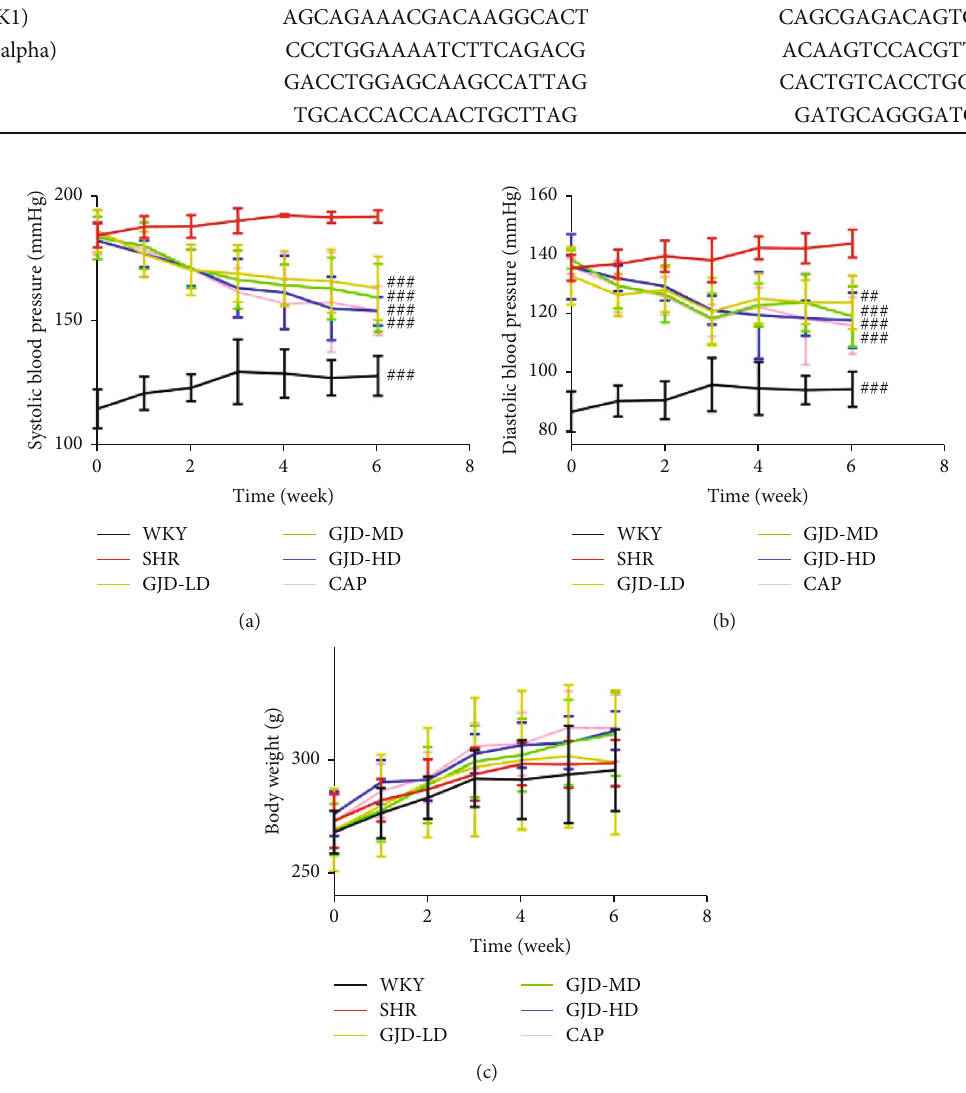
Figure 1: E ff ect of GJD on systolic and diastolic blood pressures and body weight. (a) SBP, (b) DBP, and (c) body weight. WKY indicates the WKY control group, SHR indicates the SHR Model group, GJD-LD indicates the SHR treated with GJD at a low dose, GJD-MD indicates the SHR treated with GJD at a medium dose, GJD-HD indicates the SHR treated with GJD at a high dose, and CAP indicates SHR treated with captopril. Data are means ± SD , n = 7 . # P < 0 : 05 , ## P < 0 : 01 , ### P < 0 : 001 vs. SHR